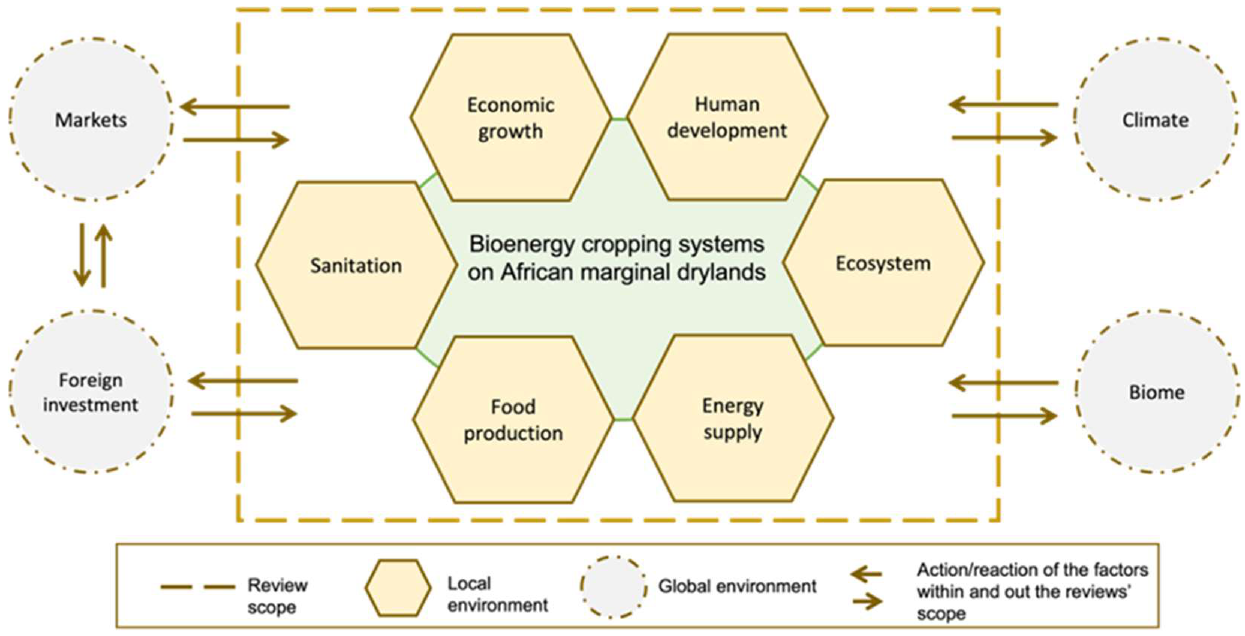
Figure 2. Overview of major factor categories, dimensional levels and interactions that address bioenergy cropping systems on marginal African drylands.